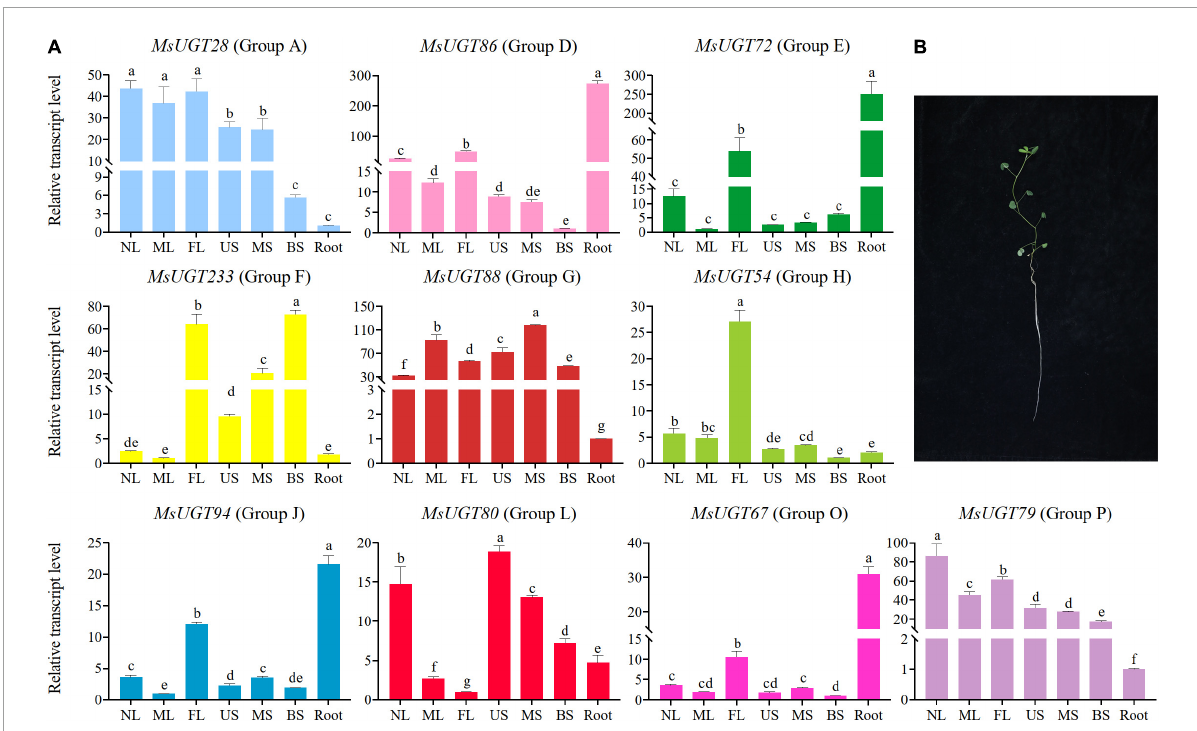
FIGURE7 Transcriptional expression analysis of Ms UGT genes of 10 groups in seven different tissues. (A) Genes of MsUGT28 , 86 , 72 , 233 , 88 , 54 , 94 , 80 , 67, and 79 were selected from groups A, D, E, F, G, H, J, L, O, and P, respectively. The gene expression represented in each evolutionary group is shown with the same color as the phylogenetic tree in Figure 2A . (B) Tissues are harvested for transcriptional expression. NL, new leaves; ML, mature leaves; FL, the first real leaves; US, Upper stems; MS, middle stems; BS, bottom stems;